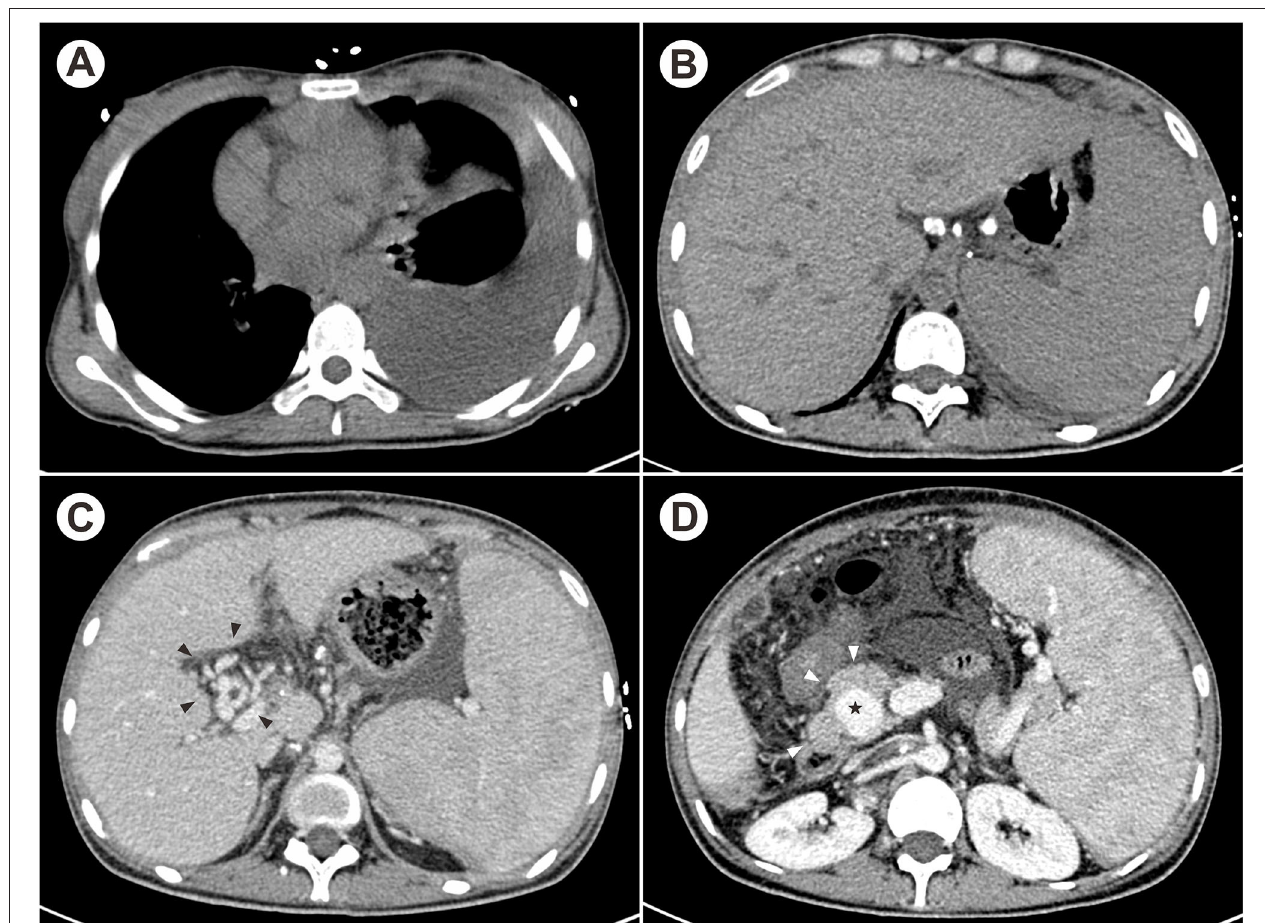
FIGURE 1 | The contrast-enhanced CT showed massive pleural effusion on the left chest (A) , multiple calcified hilar lymph nodes (B) , CTPV [ (C) , black arrowheads] and distal portal venous aneurysm [ (D) , star] due to lymphadenopathy [ (D) , white arrowheads].